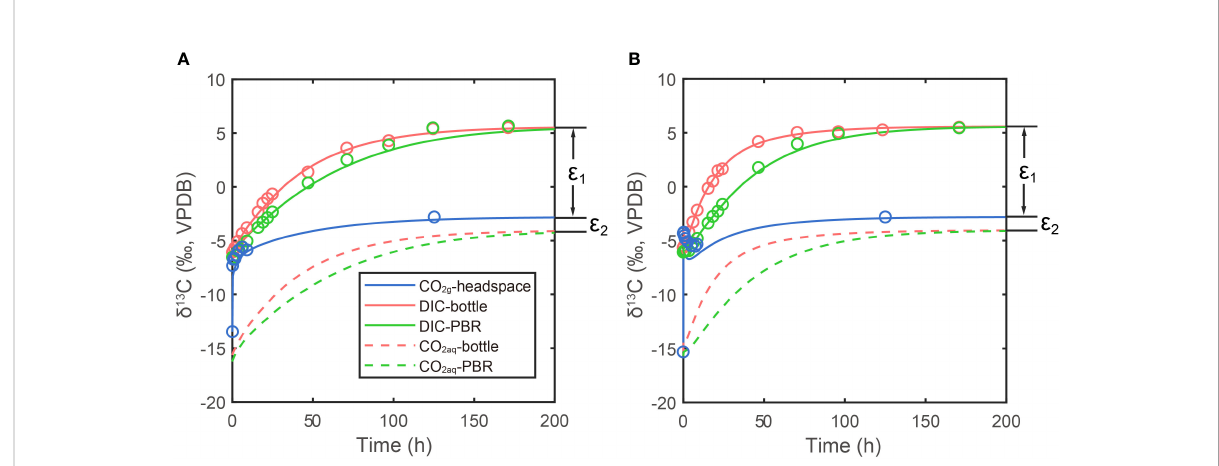
FIGURE 3 Measurements and simulations in two bubbling experiments: (A) lower CO 2 experiment in small photobioreactor system; (B) higher CO 2 experiment in large photobioreactor system. Lines are simulation results and dots are measured. Blue lines and dots are carbon isotope ratio of CO 2 (g) in headspace, red lines and dots are DIC carbon isotope in bottle and green lines and dots are DIC carbon isotope in photobioreactor (PBR in legend). Red and green dashed lines are simulated CO 2 (aq) carbon isotope ratios in bottle and photobioreactor, respectively. The ϵ 1 and ϵ 2 are carbon isotope fractionations between DIC and CO 2 (g) and CO 2 (g) and CO 2 (aq),